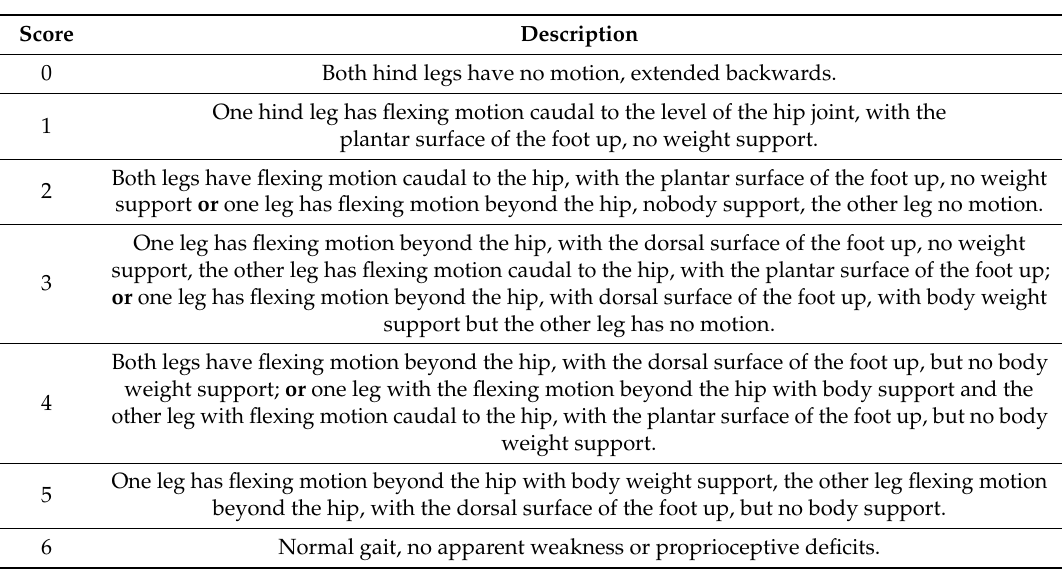
Table 2. Scoring of neurological deficits in the hind end locomotor test (HE test) in spinal cord injury rats.